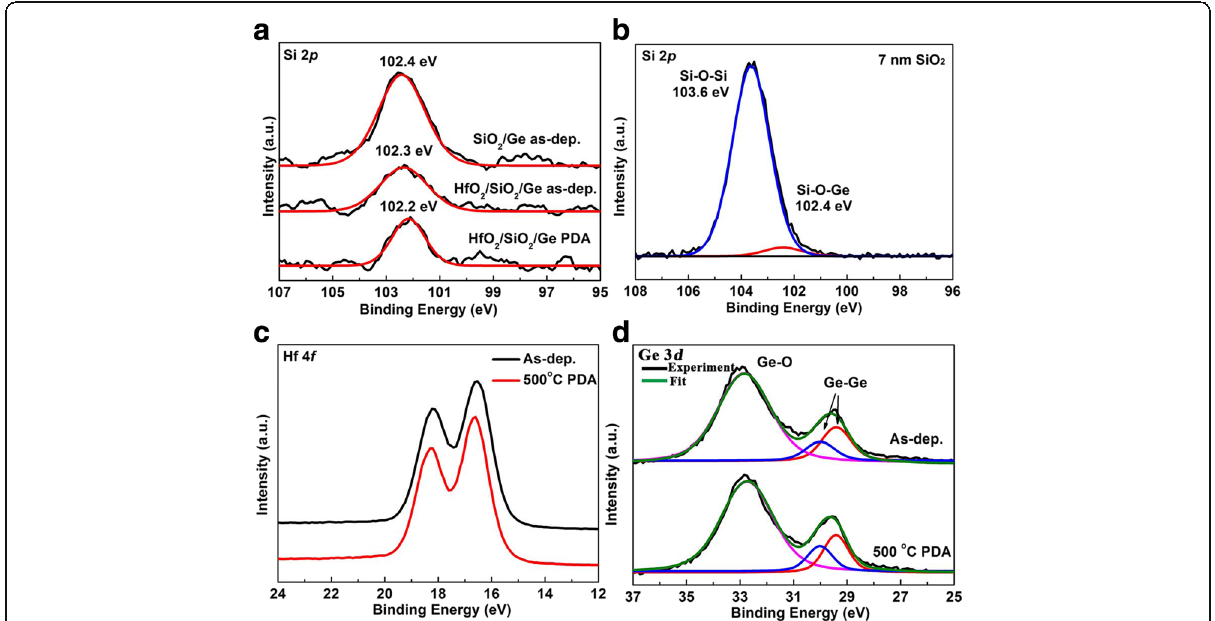
Fig. 1 XPS spectra of SiO 2 /Ge and HfO 2 /SiO 2 /Ge structures. a Si 2p spectra of SiO 2 , as-deposited and annealed HfO 2 /SiO 2 on Ge. b Si 2p spectra of thick SiO 2 (7 nm) on Ge. c, d Hf 4f and Ge 3d spectra of as-deposited and annealed HfO 2 /SiO 2 /Ge